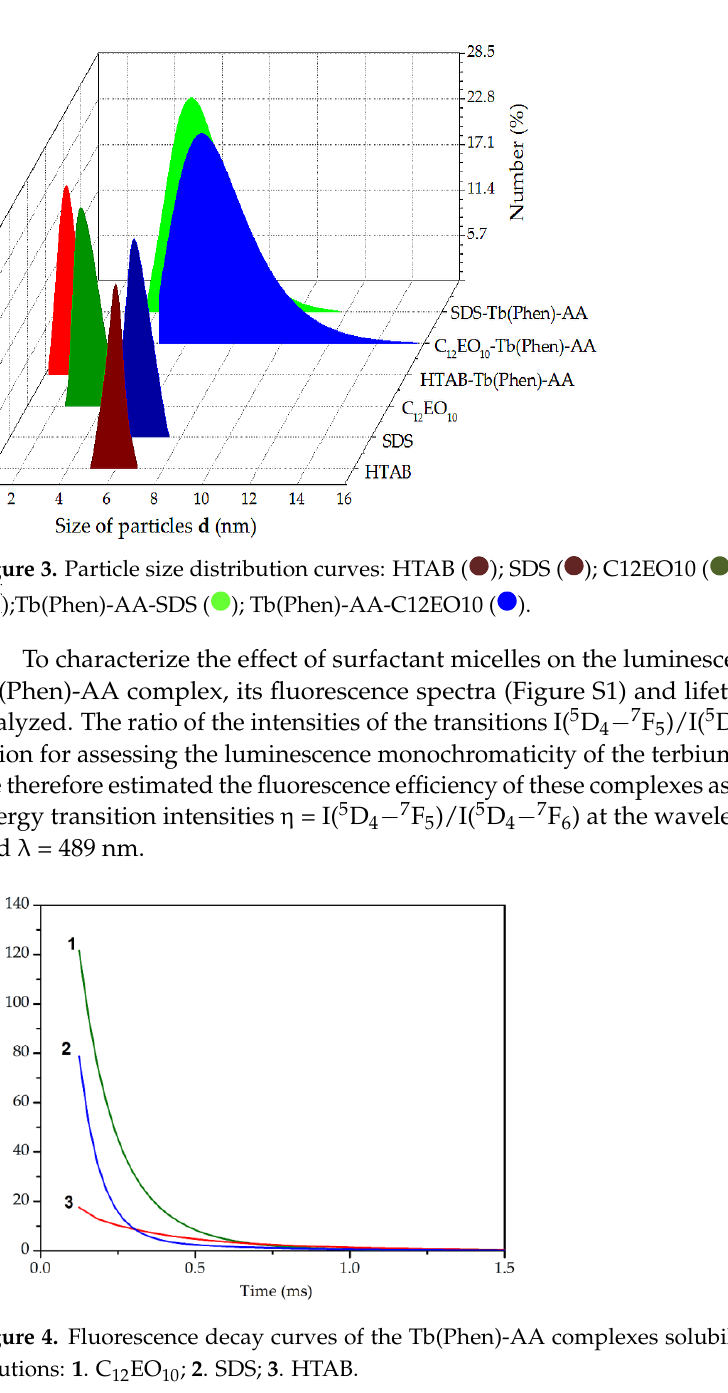
Figure 4. Fluorescence decay curves of the Tb(Phen)-AA complexes solubilized in the surfactant solutions: 1 . C 12 EO 10 ; 2 . SDS; 3 . HTAB.